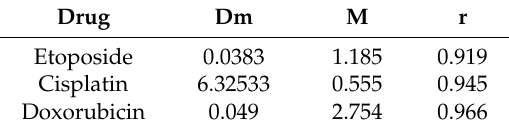
Table 3. Dose-effect relationship parameters for treatment by two-drug combinations of 122.4 with etoposide or cisplatinor doxorubicin. BS-24-1 cells were treated with the two-drug combinations. Potency, shape (sigmoidicity) and conformity of dose-effect curve (linear correlation coefficient) are represented by Dm, m, and r, respectively, where Dm (ED50) is the antilog of x-intercept in µ g/mL, m is the slope of the median-effect plot signifying the shape of the dose-effect curve (m = 1, >1 and <1 indicates hyperbolic, sigmoidal and negative sigmoidal curve, respectively), and r is the linear correlation coefficient of the median-effect plot. Data shown are pooled results of minimum of three